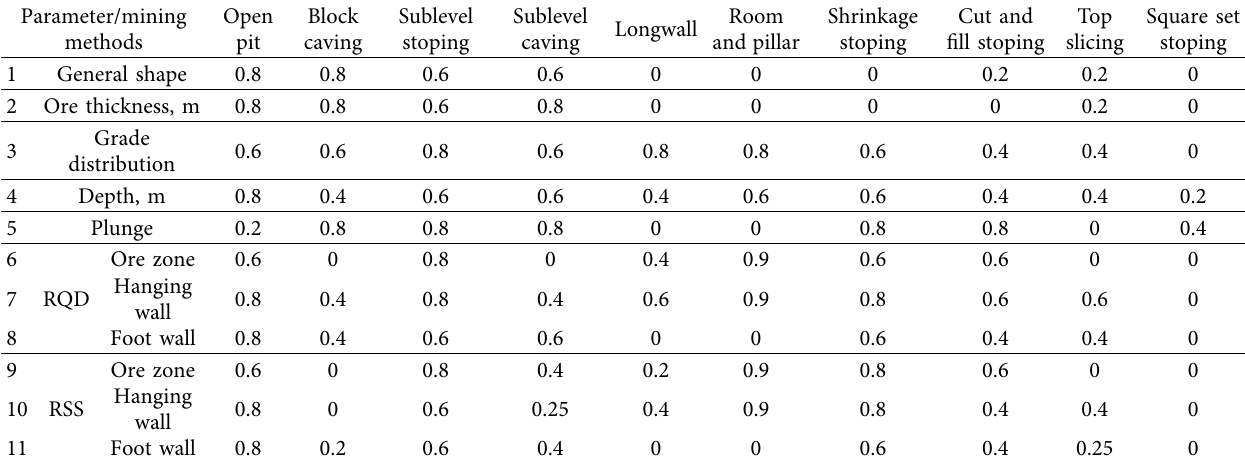
Figure 3: Trainable cascade-forward backpropagation ANN adopted to decide the suitable mining method. Table 5: Weights of the various parameter assignments based on the mining methods.